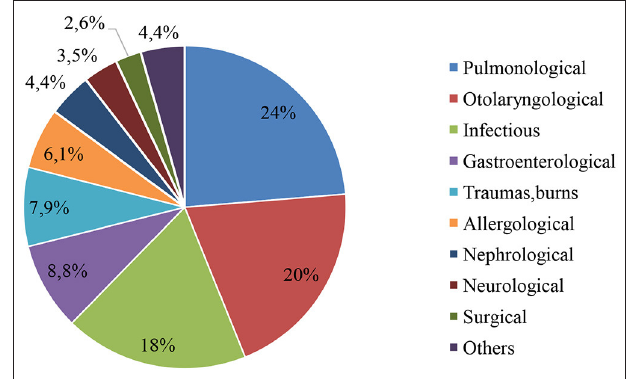
FIGURE 2 | Types of previous or existing serious diseases in the respondents.